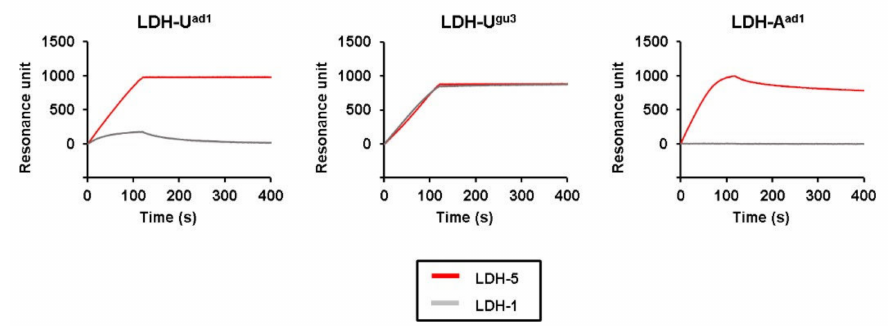
Figure A5. SPR response curve of the interaction between either LDH-5 or the salivary proteins SIgA and sAA, and the candidate aptamers LDH–A ad1 and A ad2 . LDH-5, SIgA, or sAA (400 nM each) were injected over the respective aptamer-immobilizing sensor chips for 120 s at a flow rate of 50 µ L / min. The red line represents the LDH-5 measured curve, while the blue and black lines represent the sAA and SIgA recorded curves, respectively.